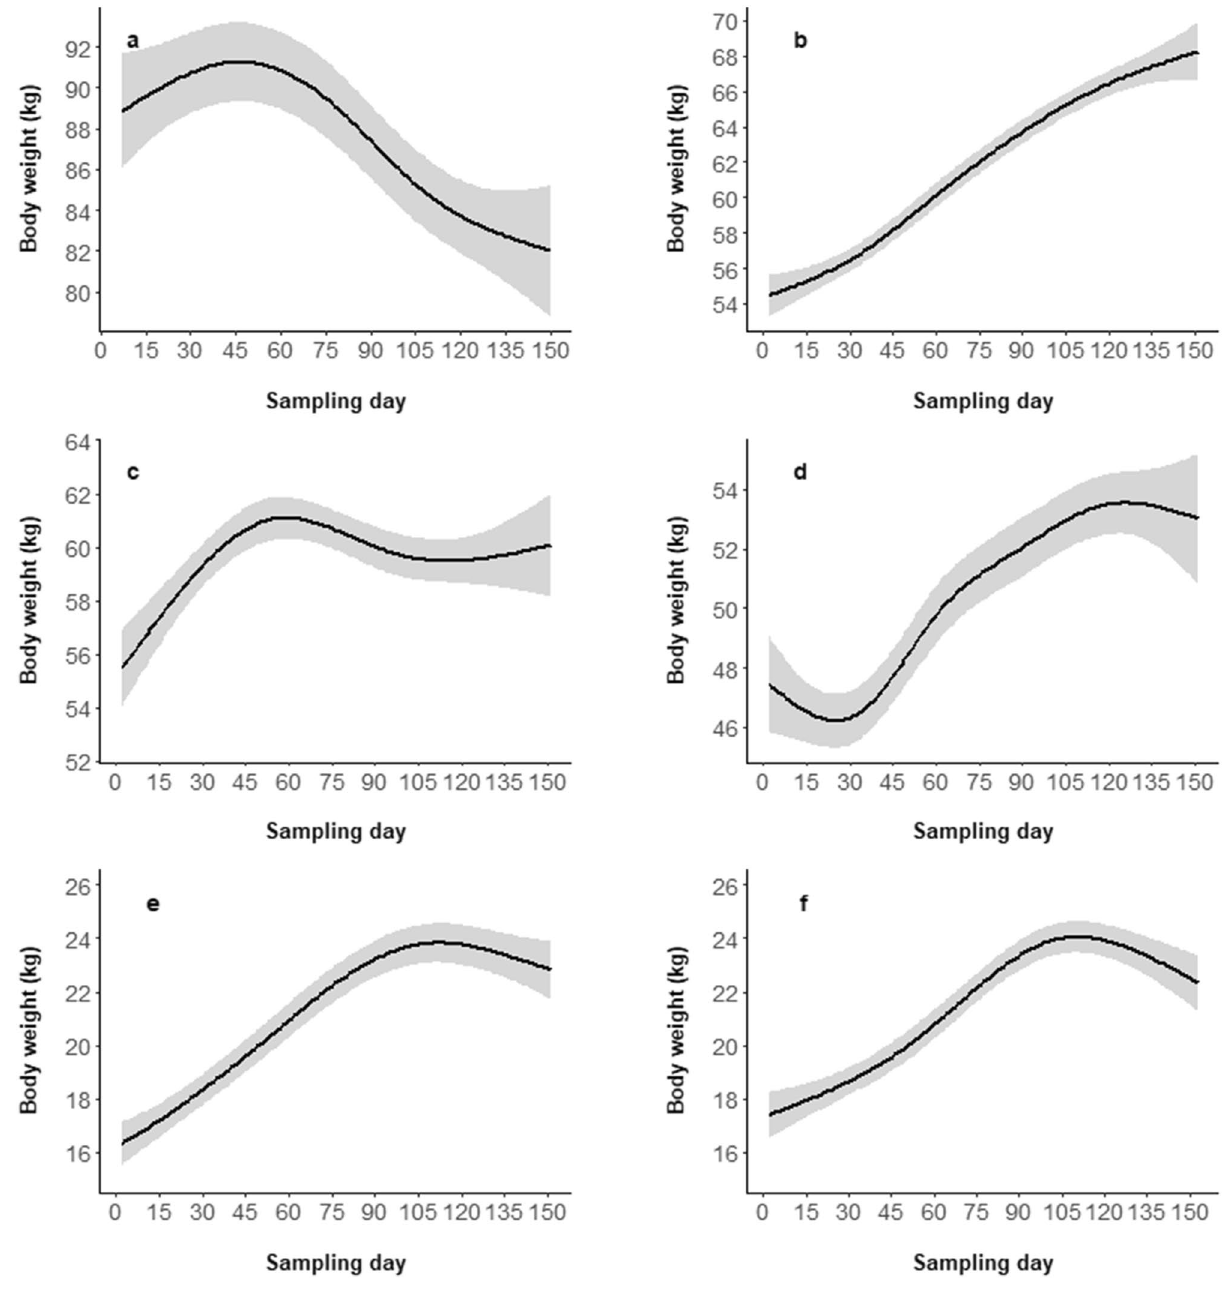
Figure 3. Body weight variation of adult males ( a ), adult females ( b ), subadult males ( c ), subadult females ( d ), male piglets ( e ), and female piglets ( f ) throughout the sampling period. The first sampling day corresponds to 1st September. Values were predicted by the best models separately for each class. Grey-shaded areas represent the estimated standard errors. The predictions are given according to the mean of all other covariates in the